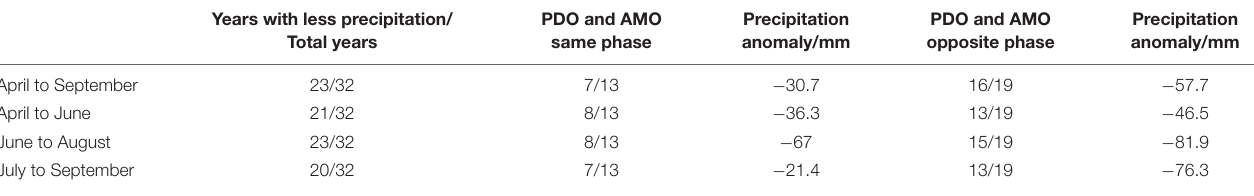
TABLE 3 | Statistics of the precipitation in Hunan flood seasons in the next years of the La Niña events during